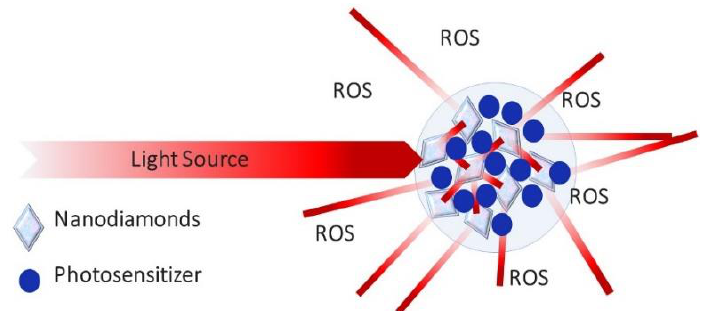
Figure 6. Schematic drawing of the promising conjugation of nanodiamonds with a photosensitizer to enhance aPDT disinfection. Nanodiamonds can act as photosensitizers by themselves, increasing the generation of reactive oxygen species and killing efficiency against biofilms.